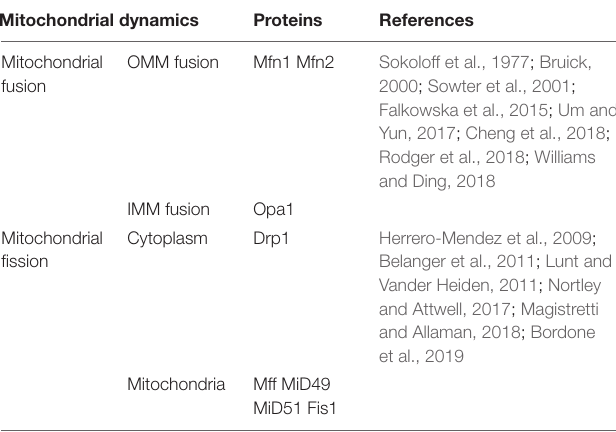
TABLE 1 | Mitochondrial dynamics related